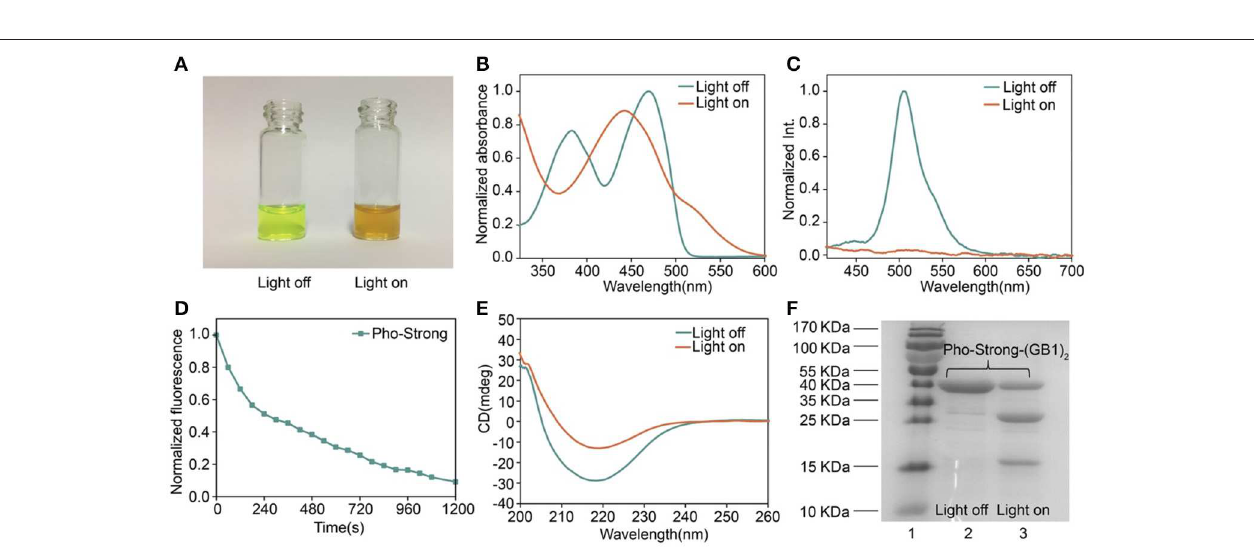
FIGURE 4 | Characterization of Pho-Strong. (A) Photographs of Pho-Strong solutions before and after light illumination. (B) UV–vis absorbance changes after photocleavage. (C) Fluorescence spectra before and after photocleavage excited at 405nm. (D) Kinetics of dissociation, as determined by the decrease of green fluorescence after illumination. (E) Circular dichroism spectra before and after photocleavage. (F) SDS-PAGE analysis of Pho-Strong-(GB1) 2 before and after photocleavage. The band at ∼ 13 kDa corresponds to the fragment containing (GB1) 2 . thiol: Mal = 1:1) at dark to form Pho-Strong-PEG